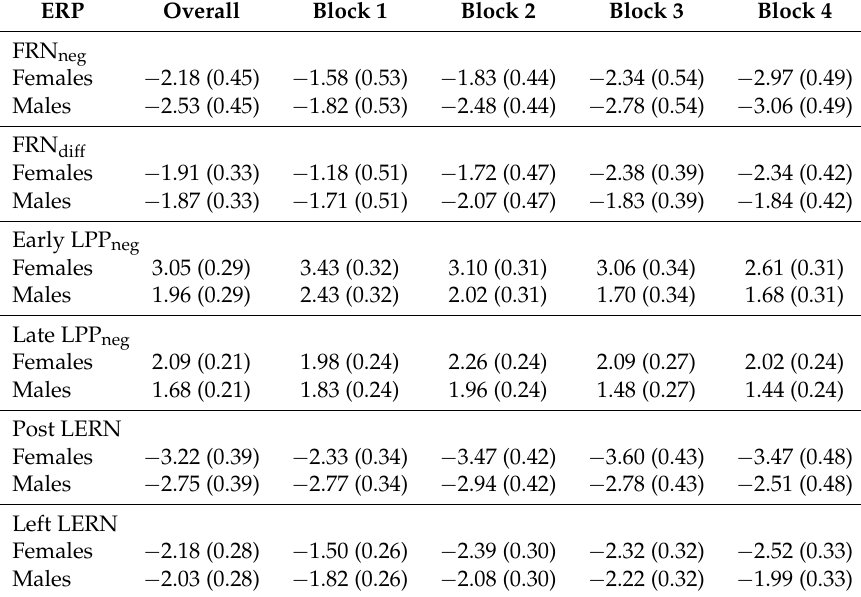
Table 4. Event-Related Potential amplitudes ( µ V). Means are adjusted for BDI-II, Brooding, and Reflection covariates.